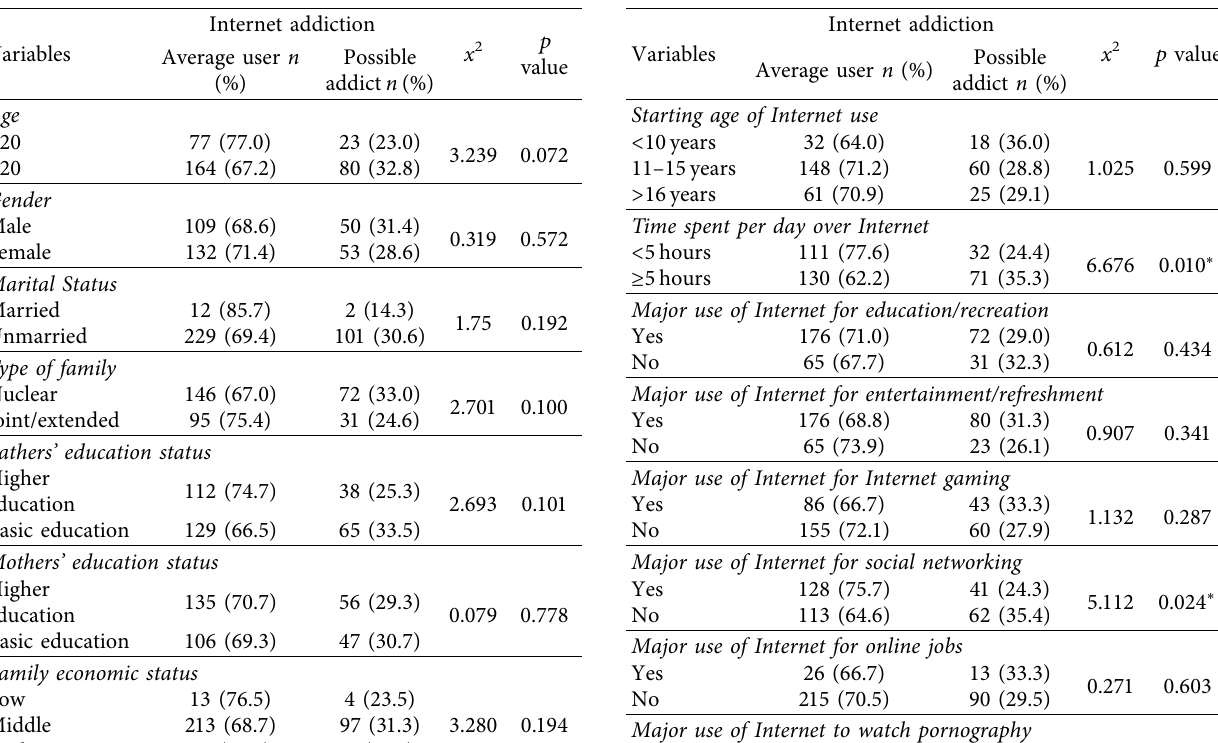
Table 5: Internet addiction and its association with the Internet use pattern.